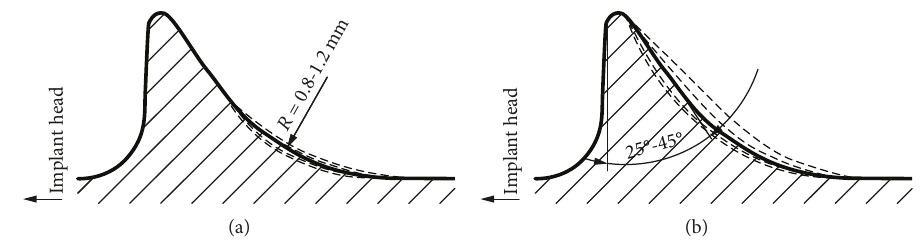
Figure 8: Thread geometry modi fi cations used in the study. (a) Rounding arc. (b) Flank